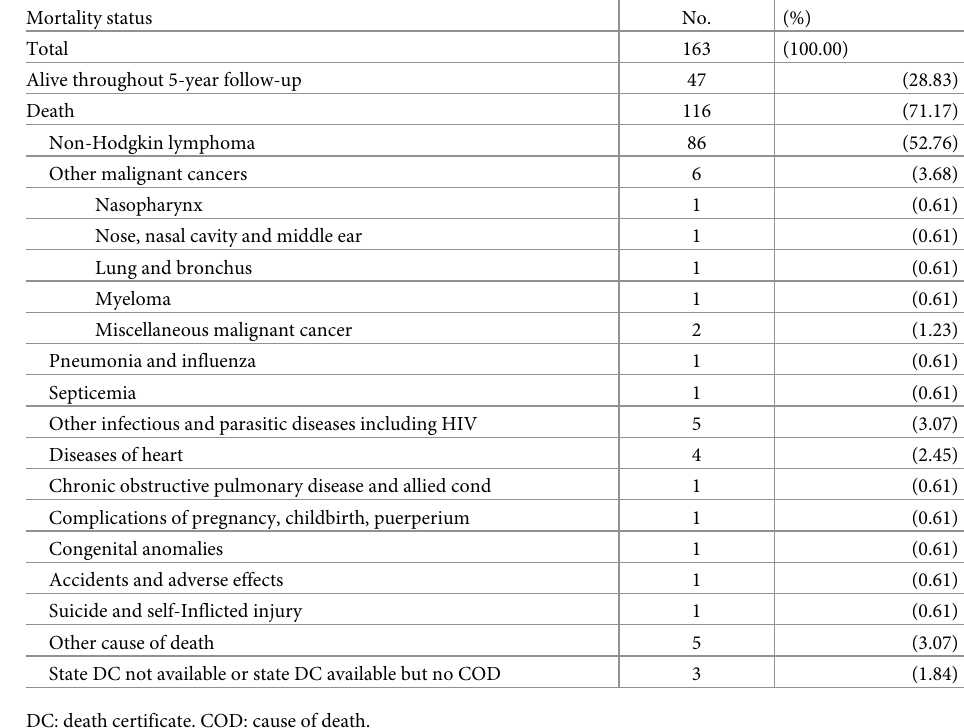
Table 4. Distribution of causes of death of follow-up in patients with extra nodal natural killer/T-cell lymphoma, nasal type, 1987–2014.